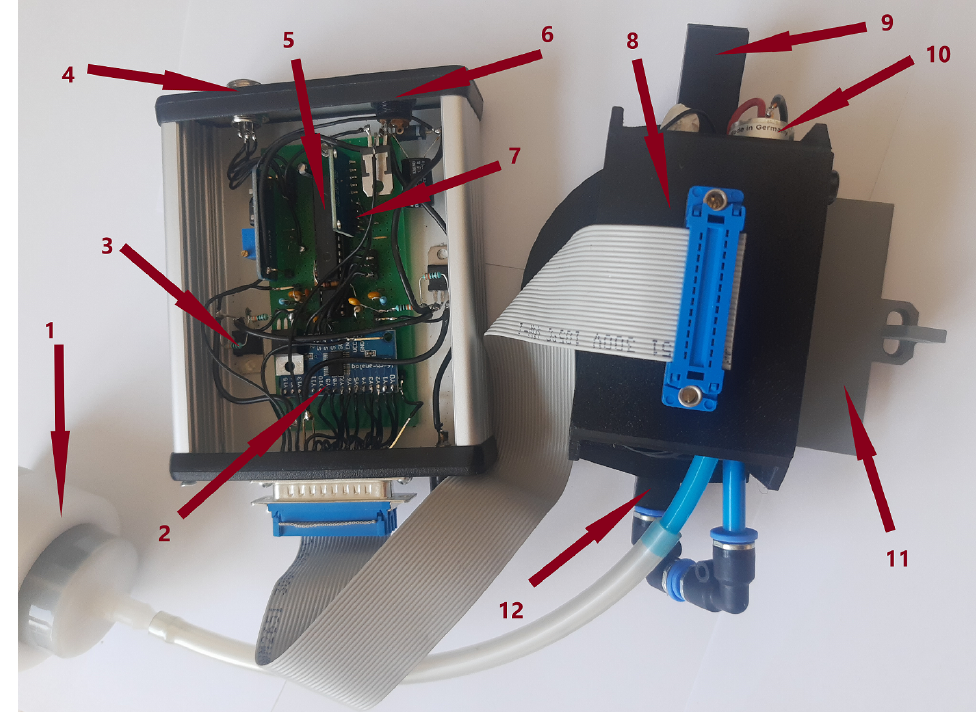
Figure 1. Photo of the electronic nose electrical device. The indicated components are as follows: 1—charcoal filter, 2—16-channel multiplexer CD74HC4067M, 3—heaters voltage stabilizer,